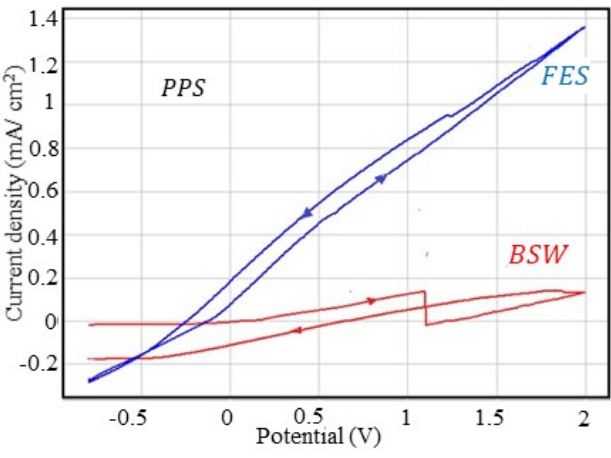
Figure 6. Cyclic voltammograms for the OPS sample. Table 15. Stimulated corrosion parameters for the PPS sample in the three corrosion environments. Corrosive